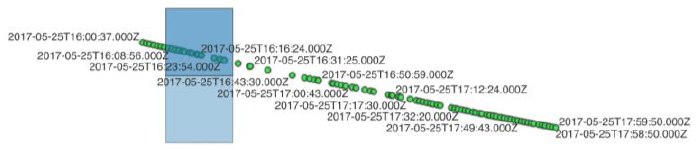
Figure 2. The output of SRP for ship 26, when using KNN.